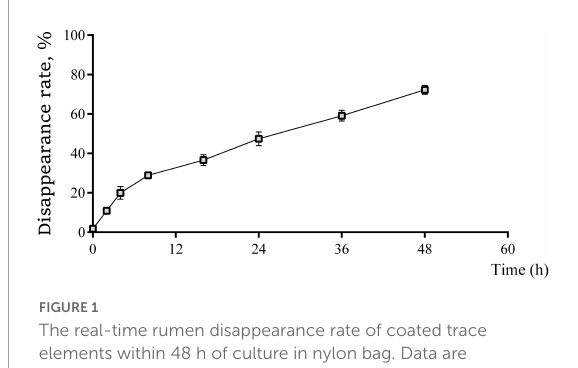
FIGURE1 The real-time rumen disappearance rate of coated trace elements within 48 h of culture in nylon bag. Data are represented as mean and standard deviation, n =